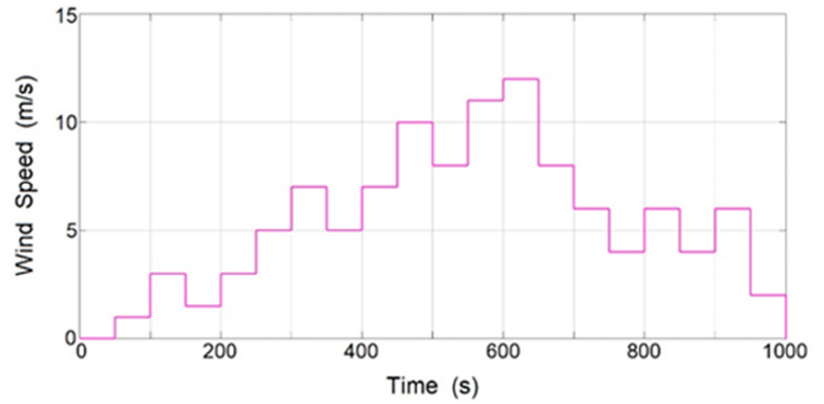
Figure 16. Wind speed values used for simulation. In the first 100 s, there are winds corresponding to region 1. Between 100 and 450 s, the wind turbine is maintained in region 2 with values lower than the nominal speed. After 450 s, the wind turbine is in region 3. Only between 600 s and 650 s are there values from region 4.